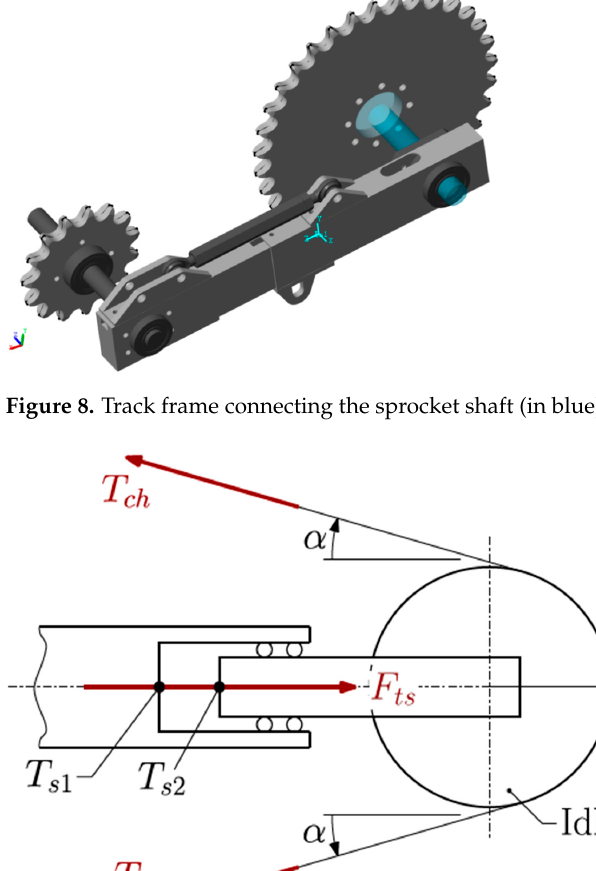
Figure 7. Track frame connecting the sprocket shaft and the idler shaft.